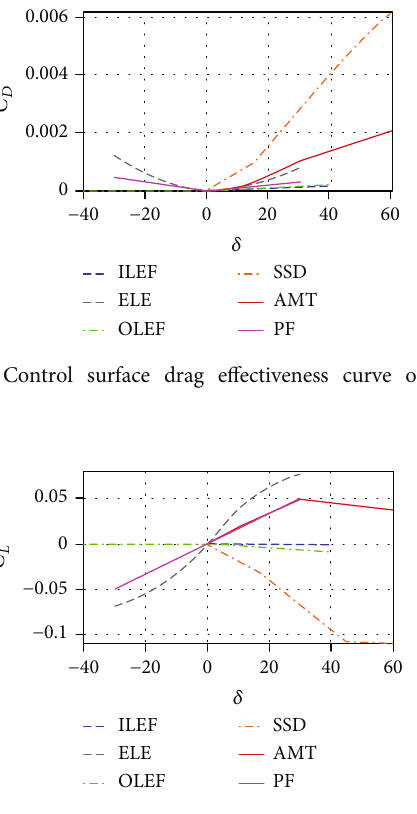
Figure 6: Lift e ff ectiveness curve of control surface of tailless aircraft.